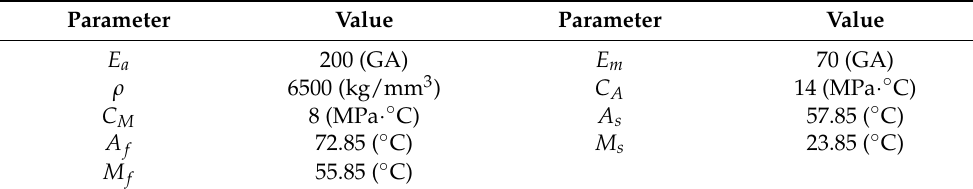
Table 1. SMA (Ni 51 Ti 49 (at. %)) material